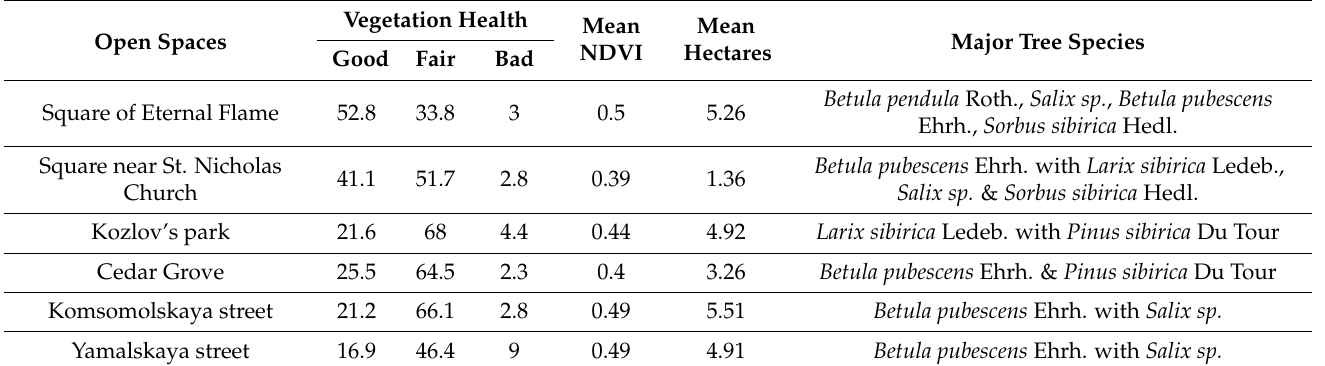
Table 2. Characteristics of trees in the major open green